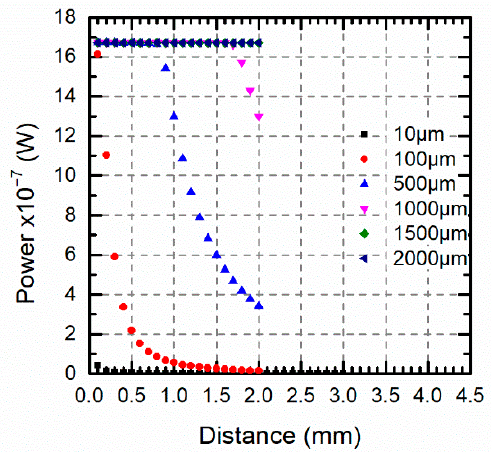
Figure 11. Pyrometer optical power versus the target-fiber distance for different target sizes in a single channel around 1550 nm at 1000 °C.